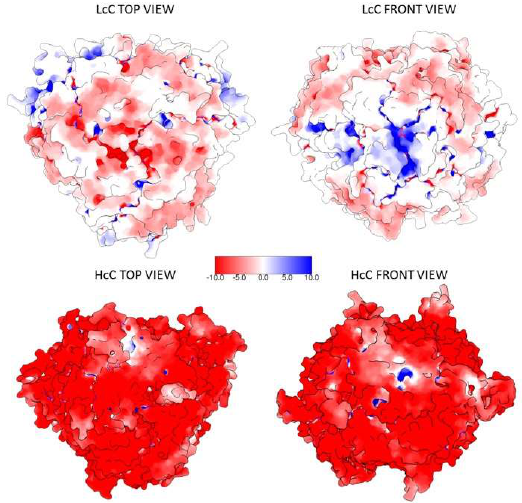
Figure 2. Electrostatic surface potential representation of the putative LcC (AAS67036.1) and HcC (XP_021752668.1) proteins, calculated at pH 8.0. Red: negative potential, blue: positive